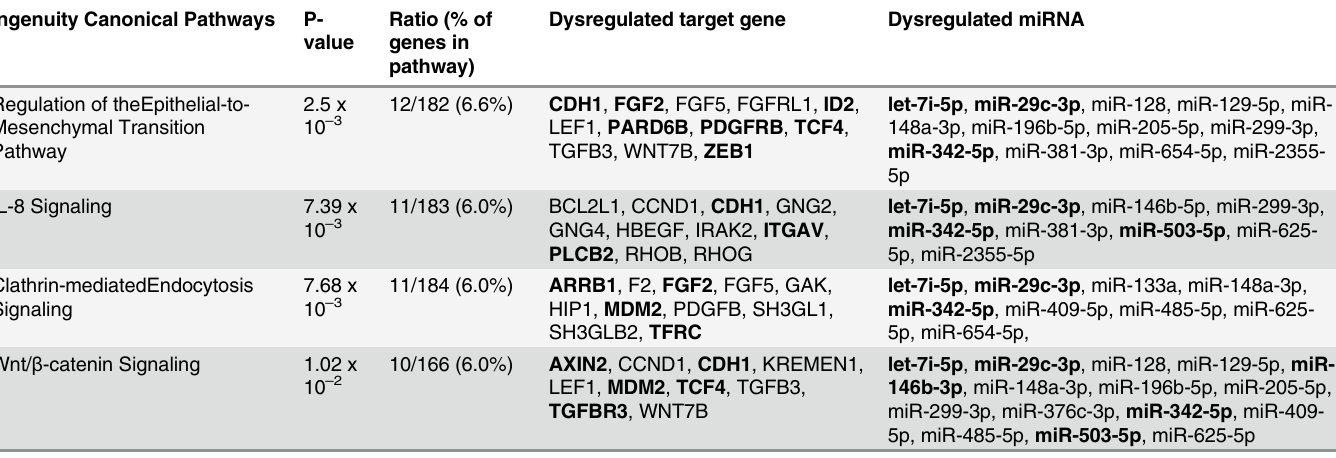
Table 4. Canonical pathways affected by differentially expressed miRNA-mRNA